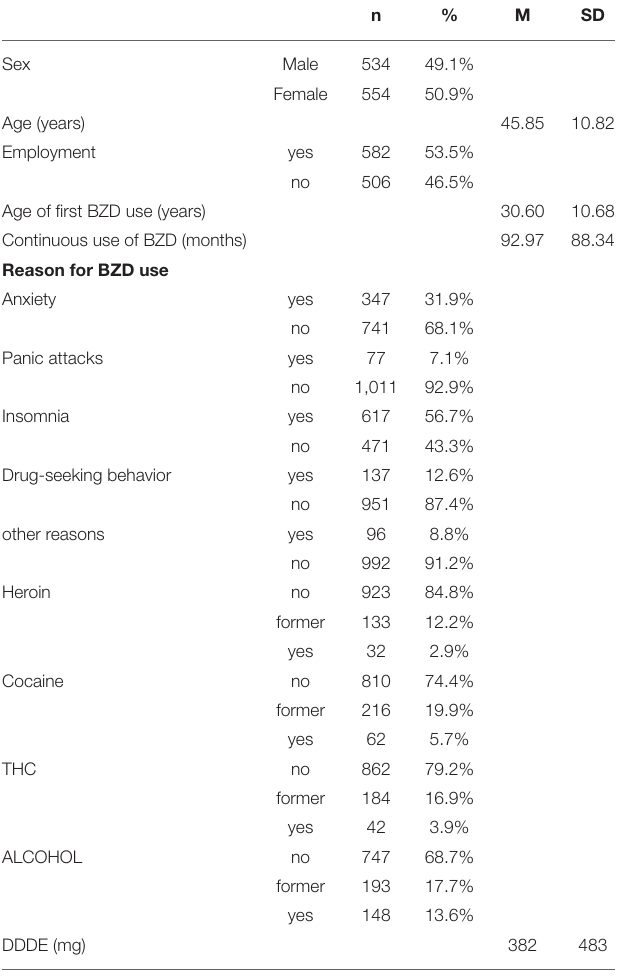
TABLE 1 | Demographic characteristics of the patients according to the type of high-dose.